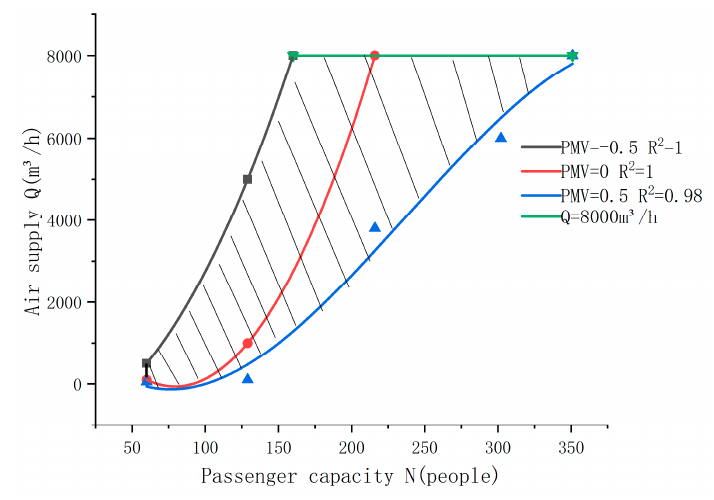
Figure 4. Variation curve of the air supply volume based on thermal comfort.